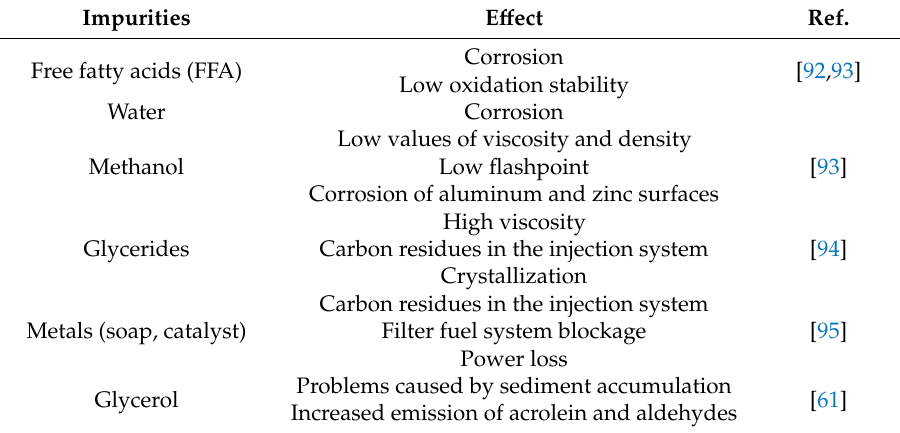
Table 8. Impurities of biodiesel and their e ff ect on combustion